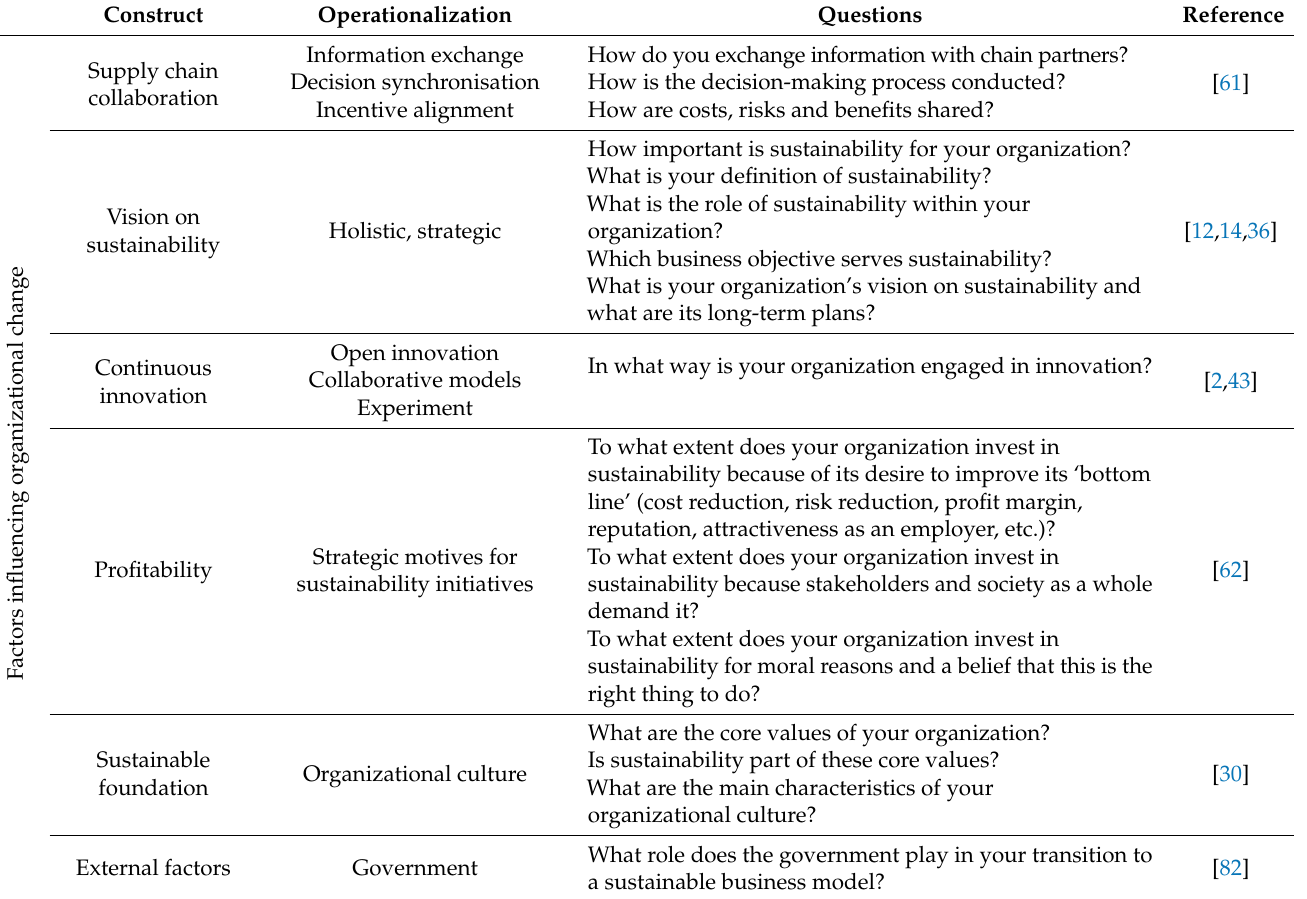
Table A3. Constructs and interview questions related to organizational